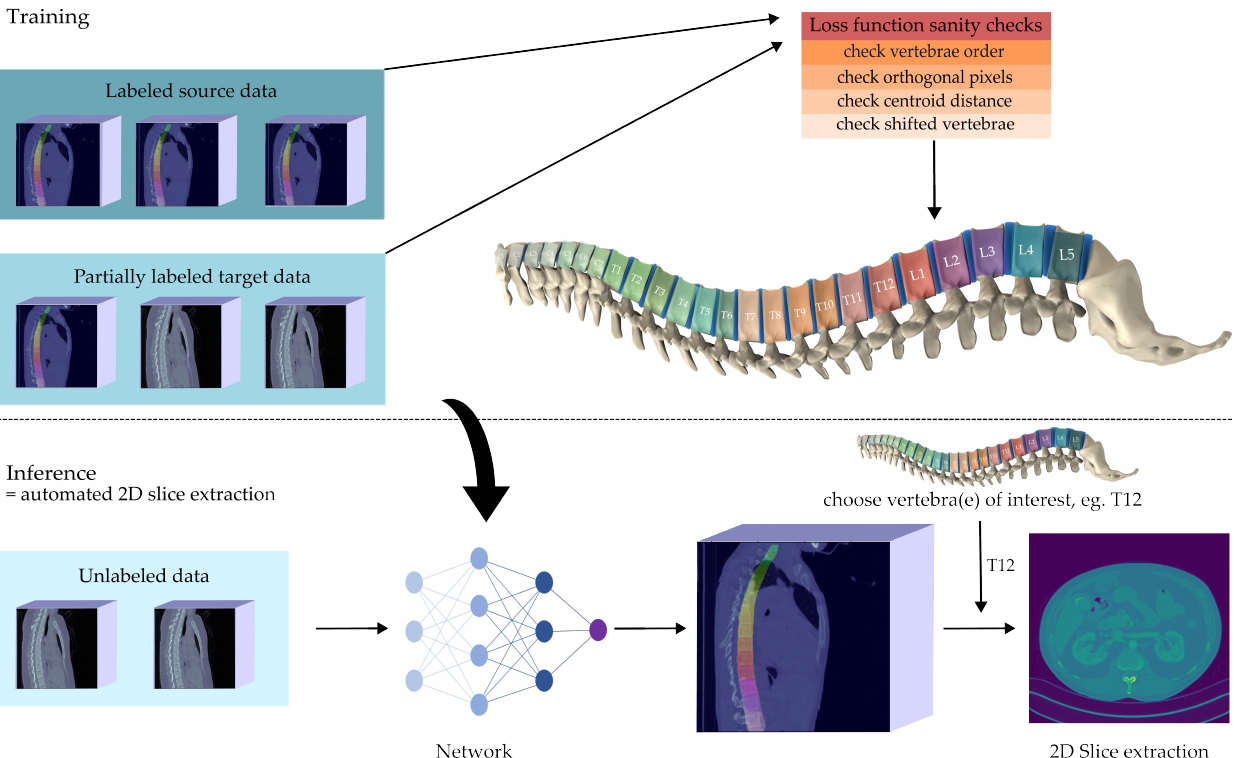
Figure 1. Visual abstract of our work: We train a vertebrae Detection and Identification module simultaneously on a publicly available data set (source domain) and a second custom data set (target domain). We require only a few labels from the custom data set. With the help of a loss function that is inspired by anatomical domain knowledge the proposed model is able to identify vertebrae centroids with state-of-the-art performance, reducing the need for target-domain labels by a factor of 20. We see its main application within ML-pipelines to extract representative 2D slices out of 3D volumes, representing a step towards fully automated systems for downstream 2D slice